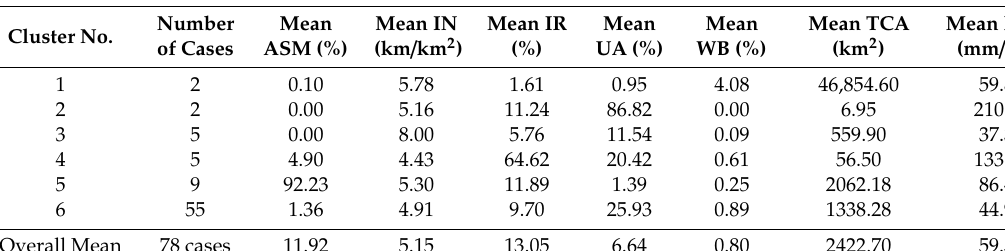
Table 5. Mean values of each cluster.